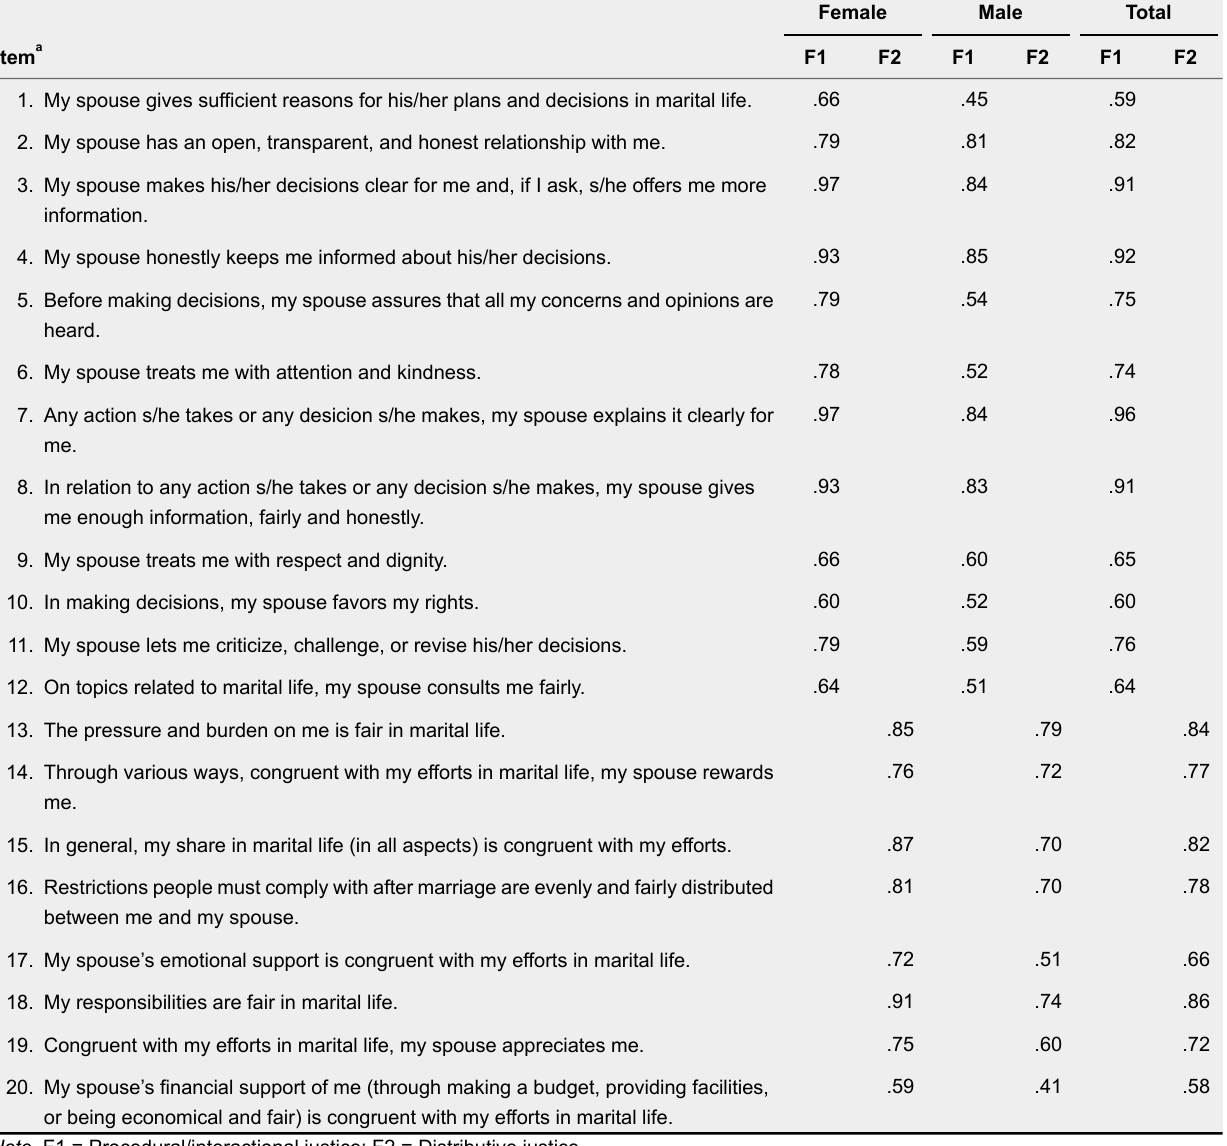
Principal Components Analysis: Oblique Rotated